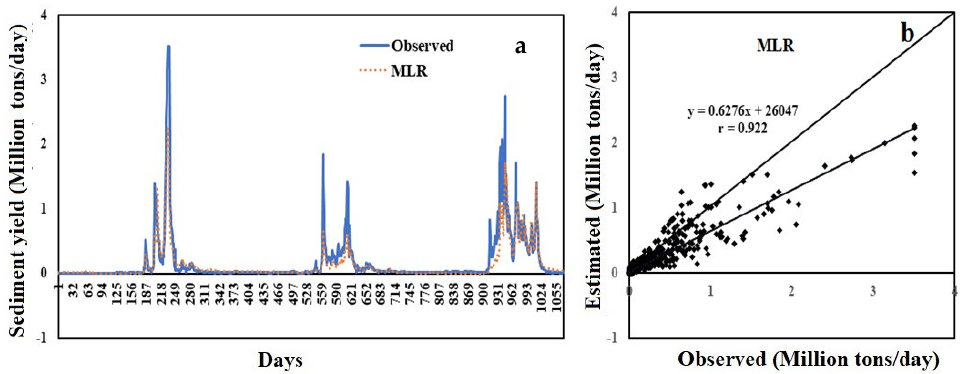
Figure 8. ( a ) Hydrograph and ( b ) scatter plot based on test data between the MLR predicted SSY and observed SSY.